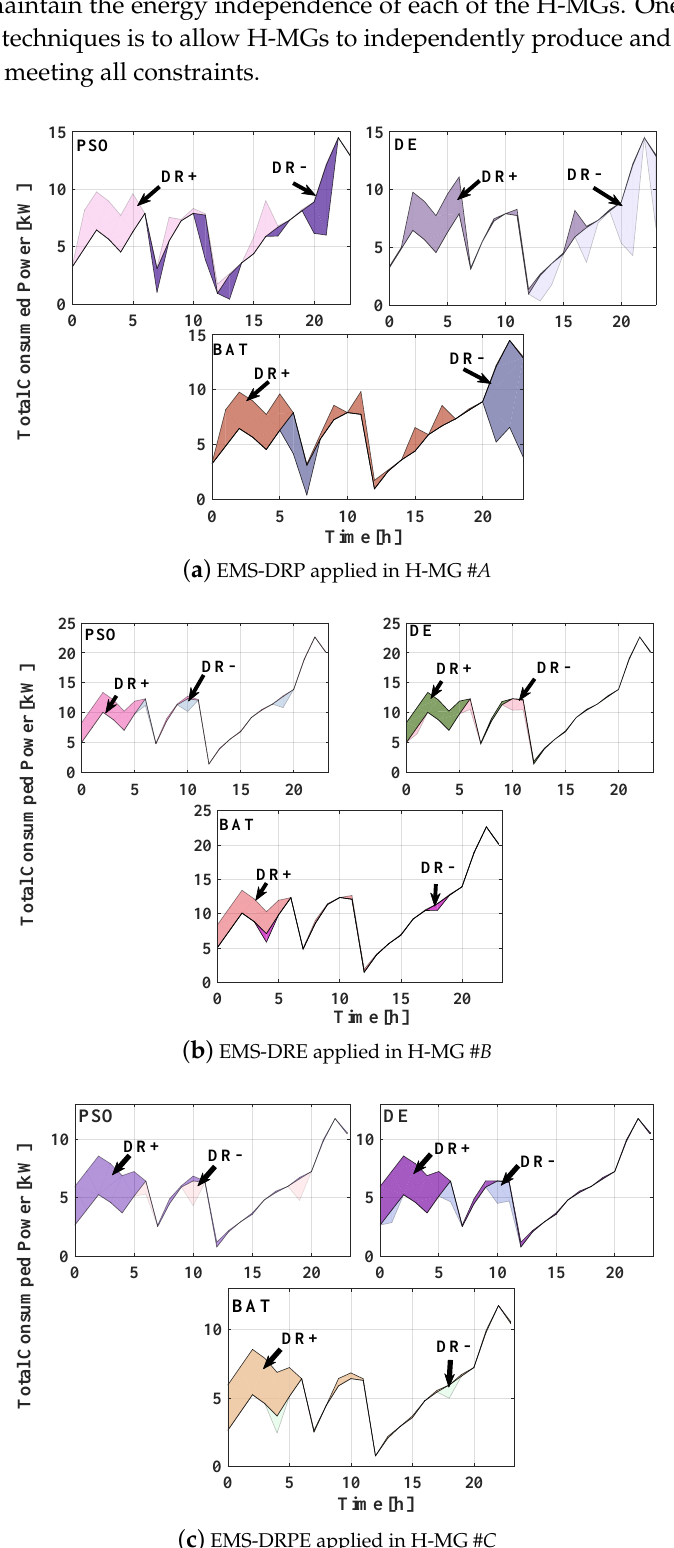
Figure 7. Load Demand Profile Consumed in: ( a ) H-MG #A; ( b ) H-MG #B; and ( c ) H-MG